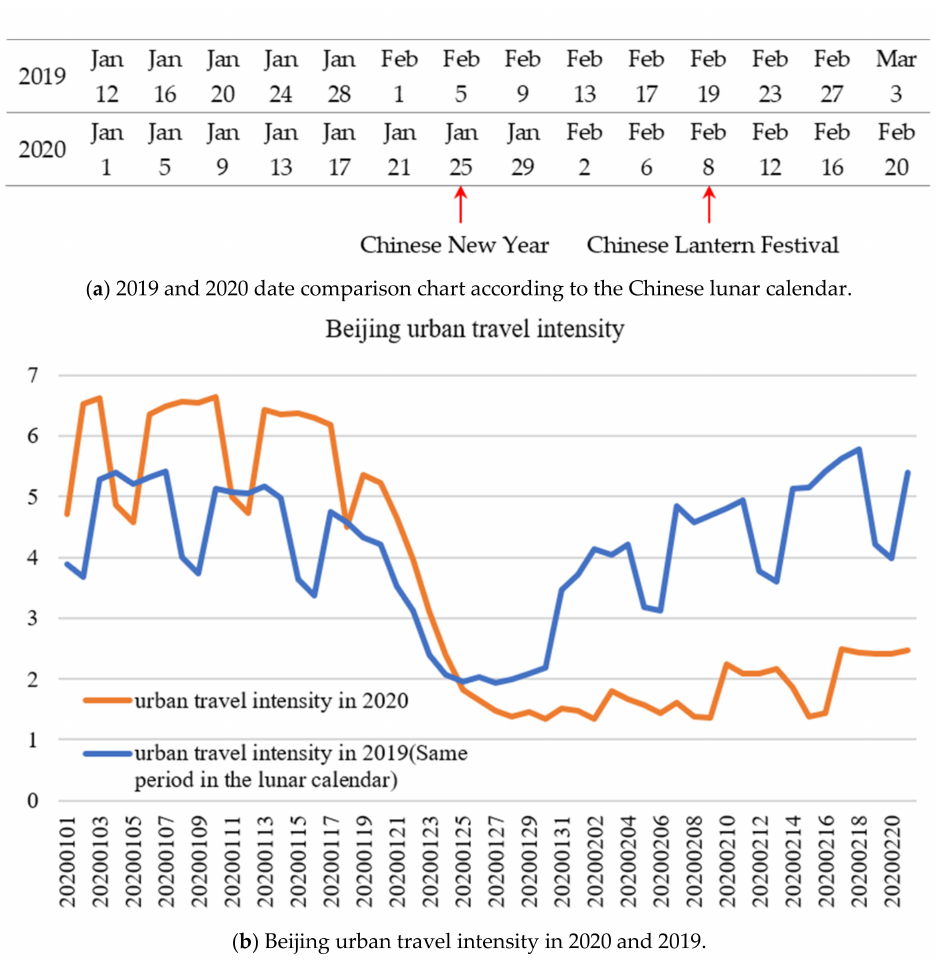
Figure 5. ( a ) According to the Chinese lunar calendar, the dates of 2019 and 2020 correspond to each other. ( b ) Beijing urban travel intensity in 2020 and 2019. According to the Chinese lunar calendar, the dates of 2019 and 2020 correspond to each other. 2019 urban travel intensity is plotted against 2020 data for the same lunar date. The corresponding date of 2019 can be found in ( a